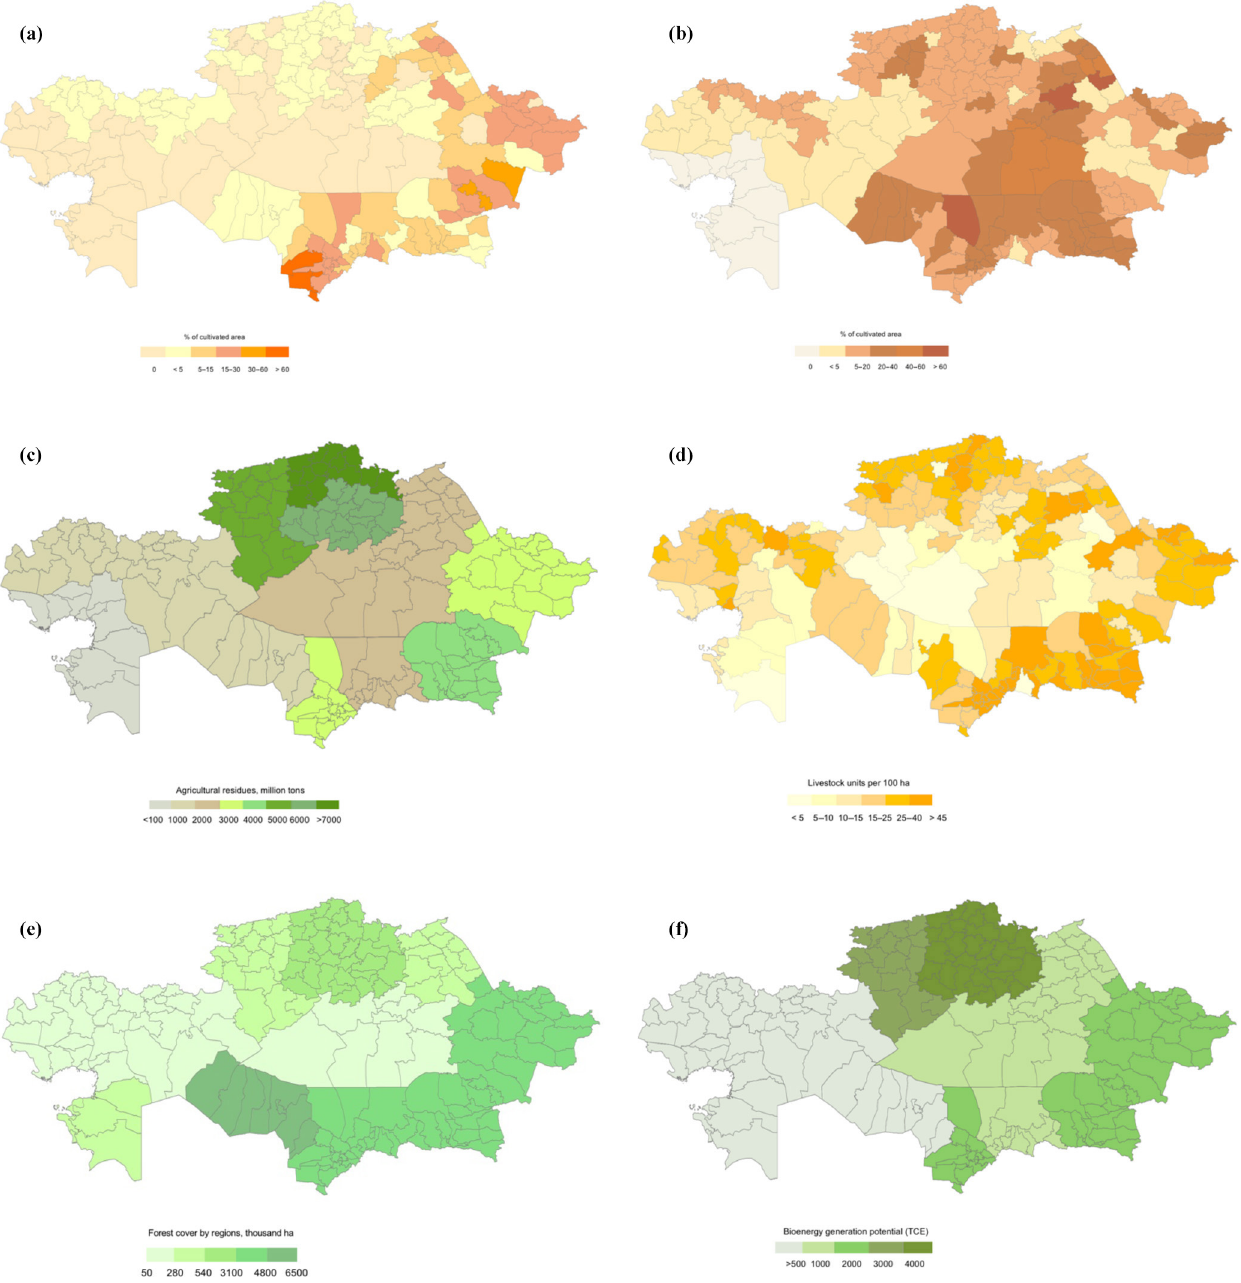
Figure 2. (a) Areas of fibre and non-grain crop production; (b) major areas of fodder crops production; (c) availability of crop residues; (d) number of livestock per 100ha; (e) forest cover in Kazakhstan; (f) energy generation potential from crop residues.